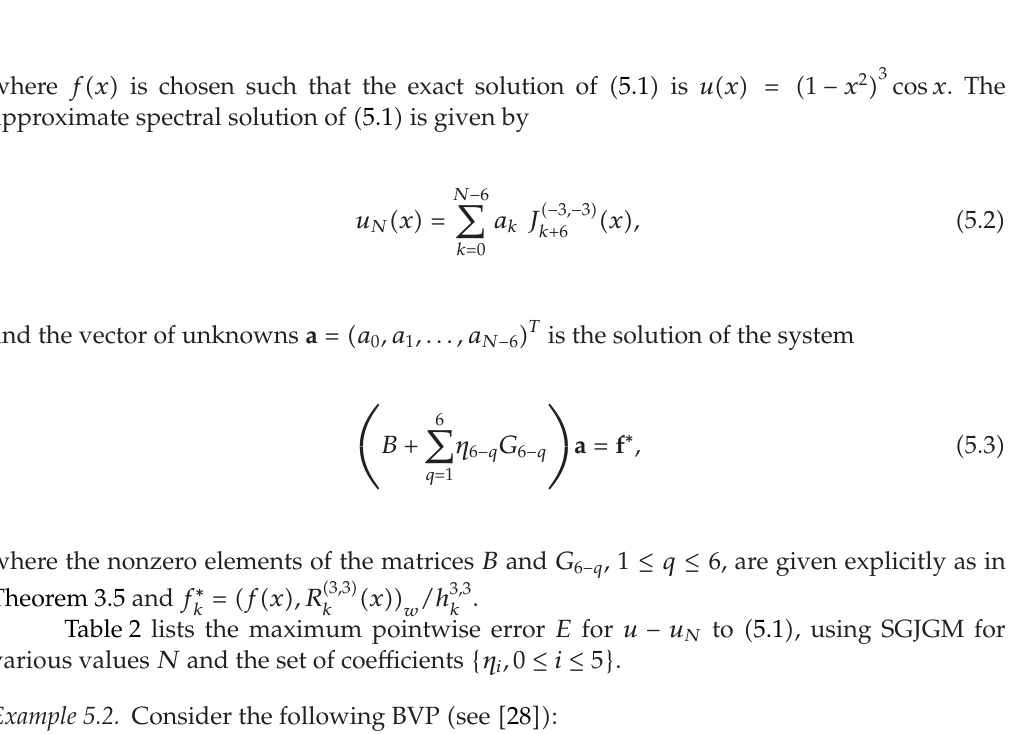
Table 2: Maximum pointwise error of u − u N η i E η